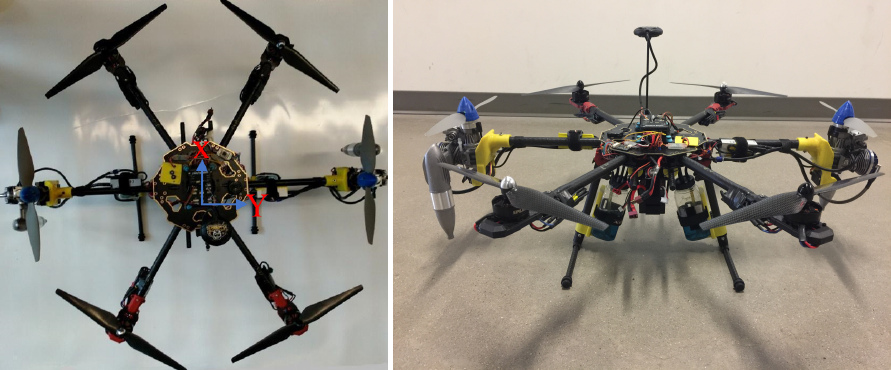
Figure 2. Hybrid hexacopter top and side